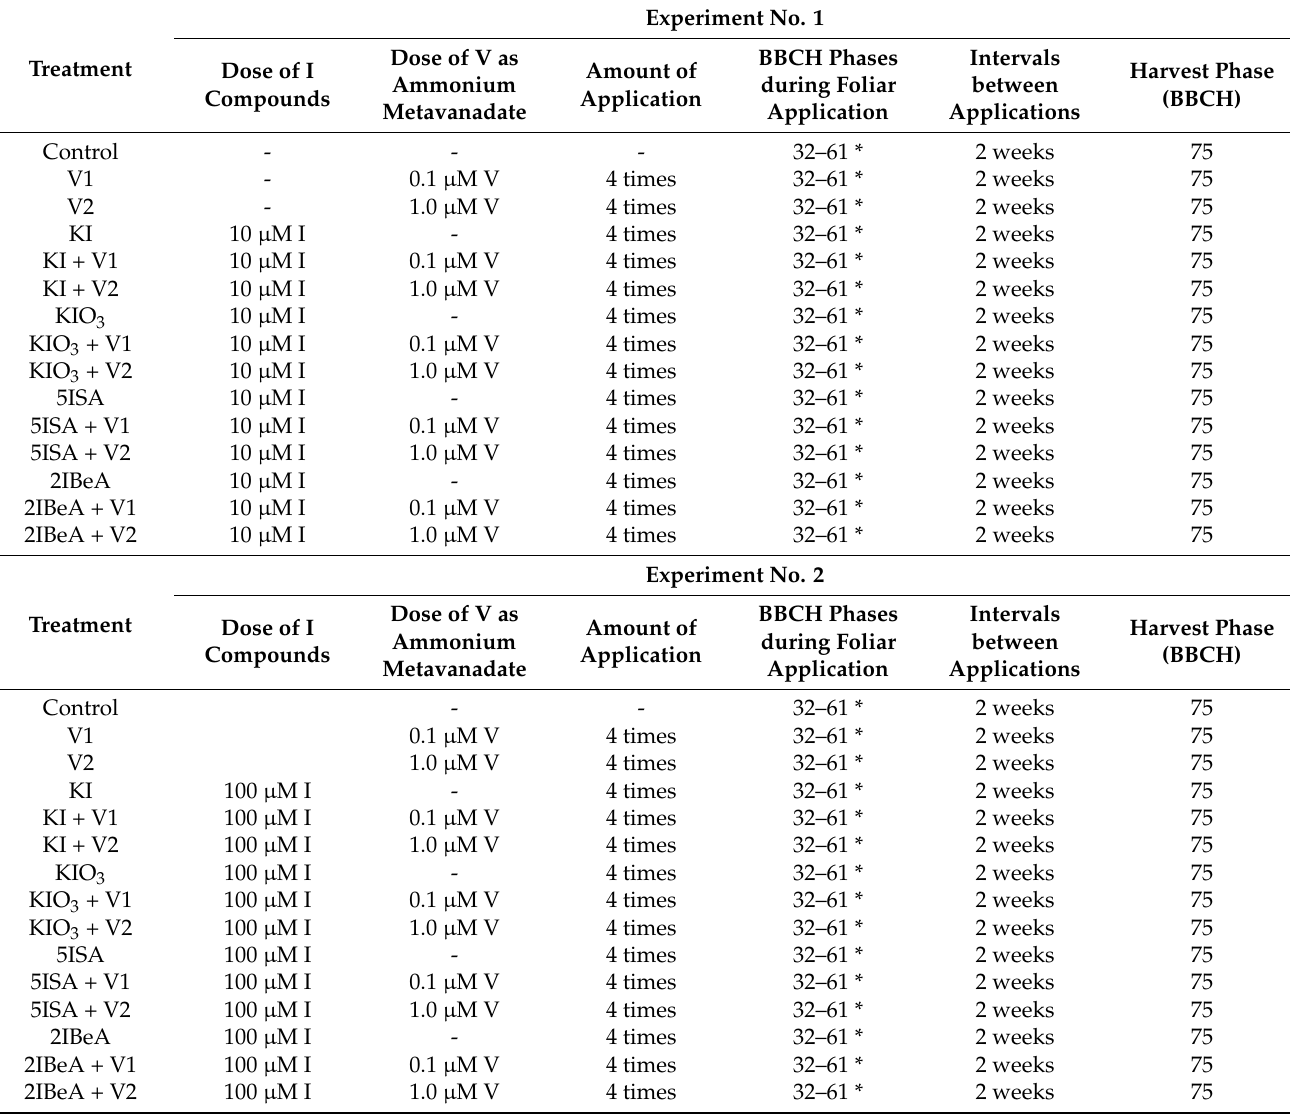
Table 6. Design and method of conducting experiments with sweet corn in field experiment; experi- ments No. 1 (2018 year) and No. 2 (2019